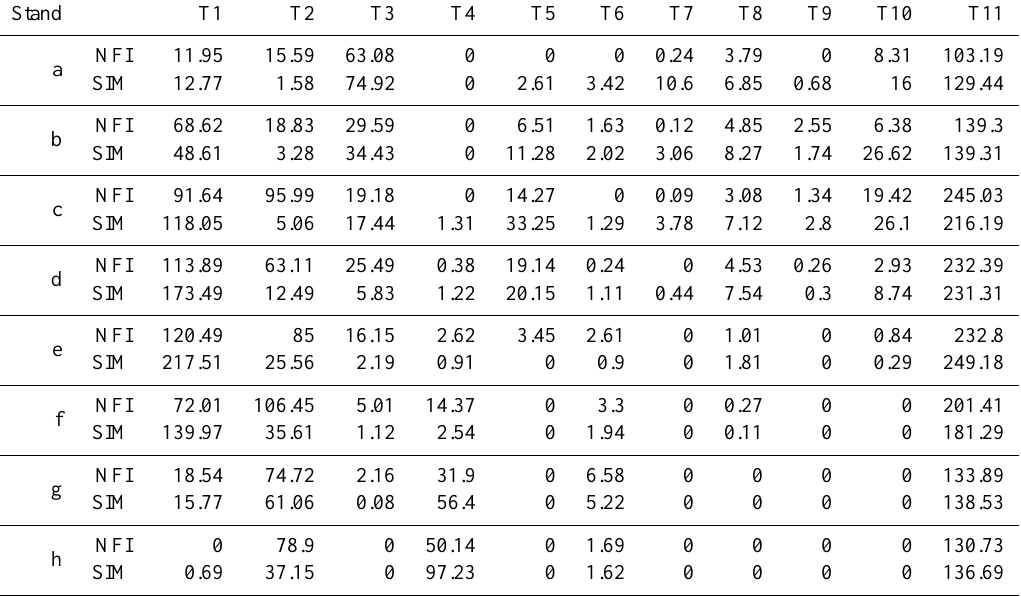
Table D4. Forest biomass of the NFI1 inventory and LPJ-GUESS results for the simulation year 1985 (all in tha − 1 ). T1: Picea abies ;